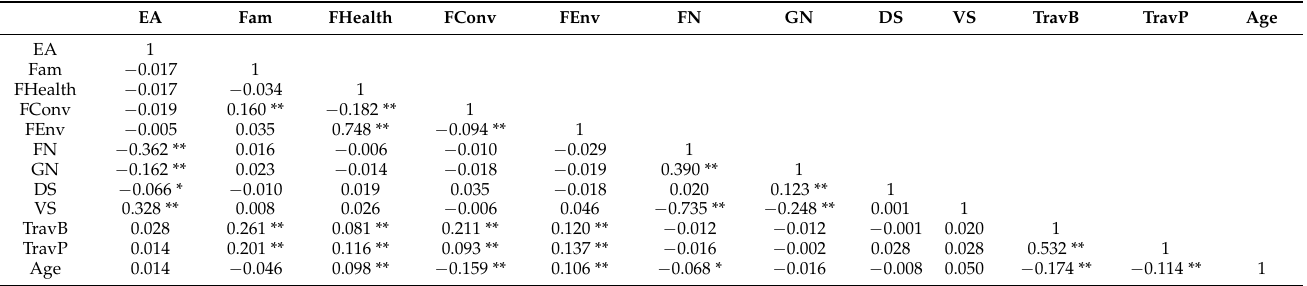
Table 2. Bivariate Pearson correlations between metric explanatory variables ( n =